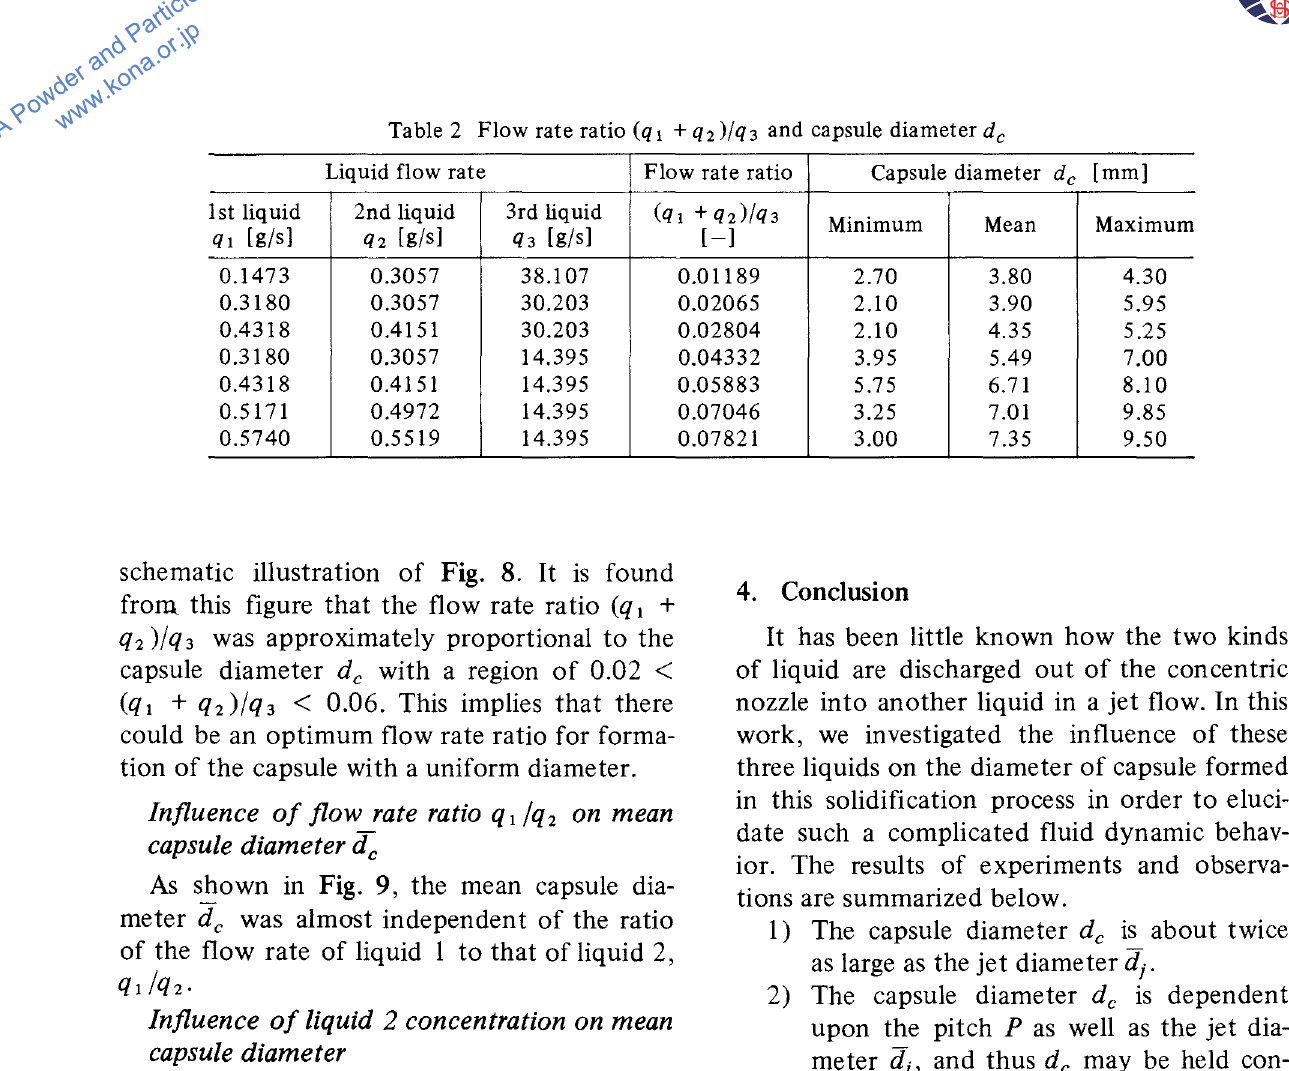
+ q 2 )/q 3 and capsule diameter 1